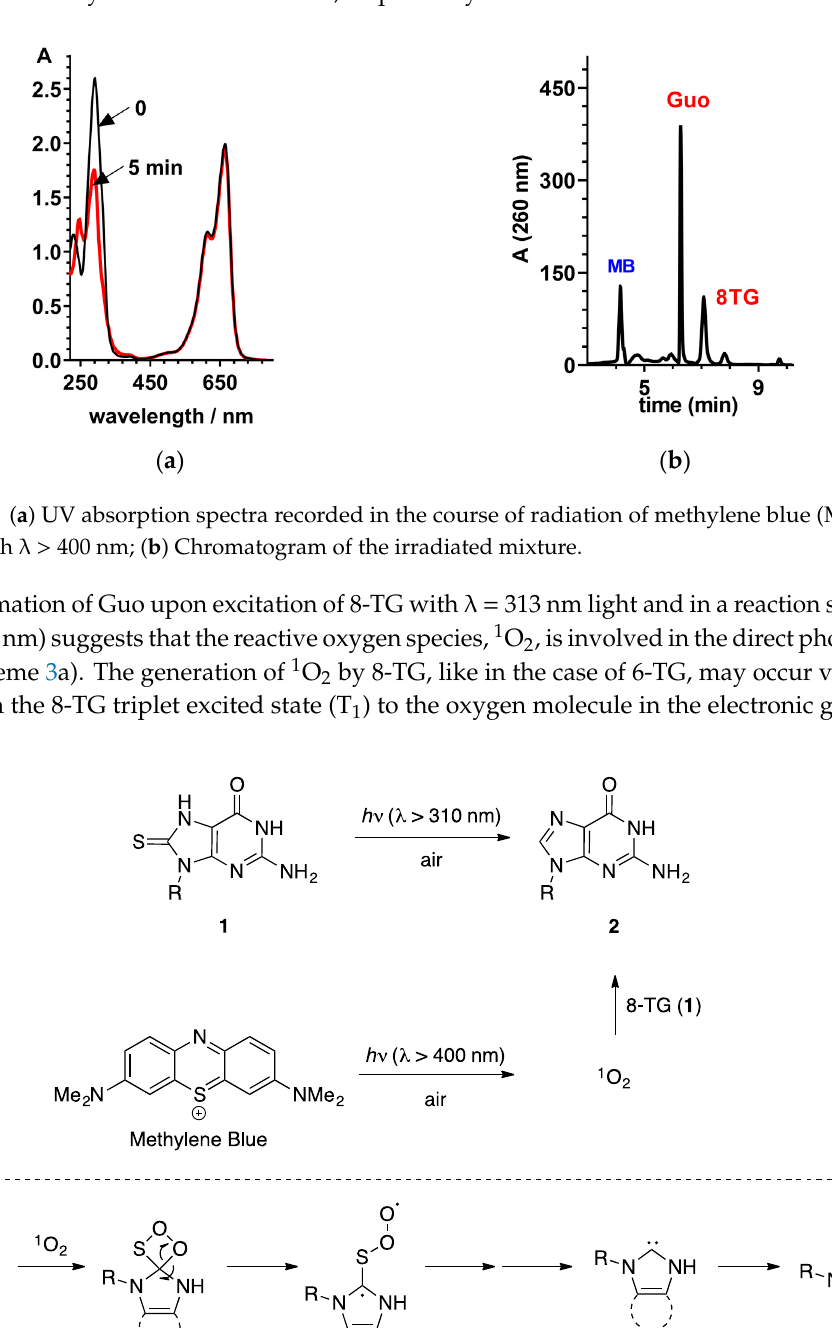
Scheme 3. ( a ) Photochemical oxidation of 8-TG and photosensitized generation of singlet oxygen; ( b ) Proposed mechanistic pathway of the 1 O 2 -promoted desulfurization of 8-TG.